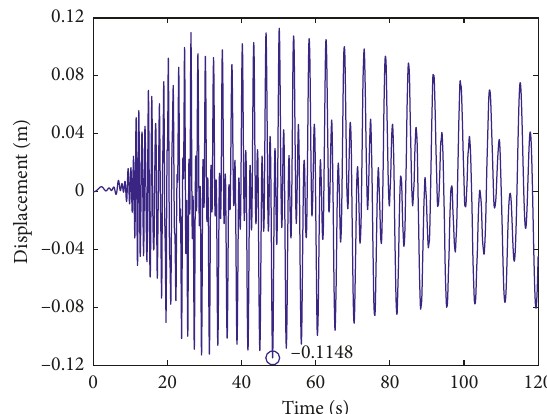
Figure 7: Total lateral vibration displacements at l enary rope in lifting.